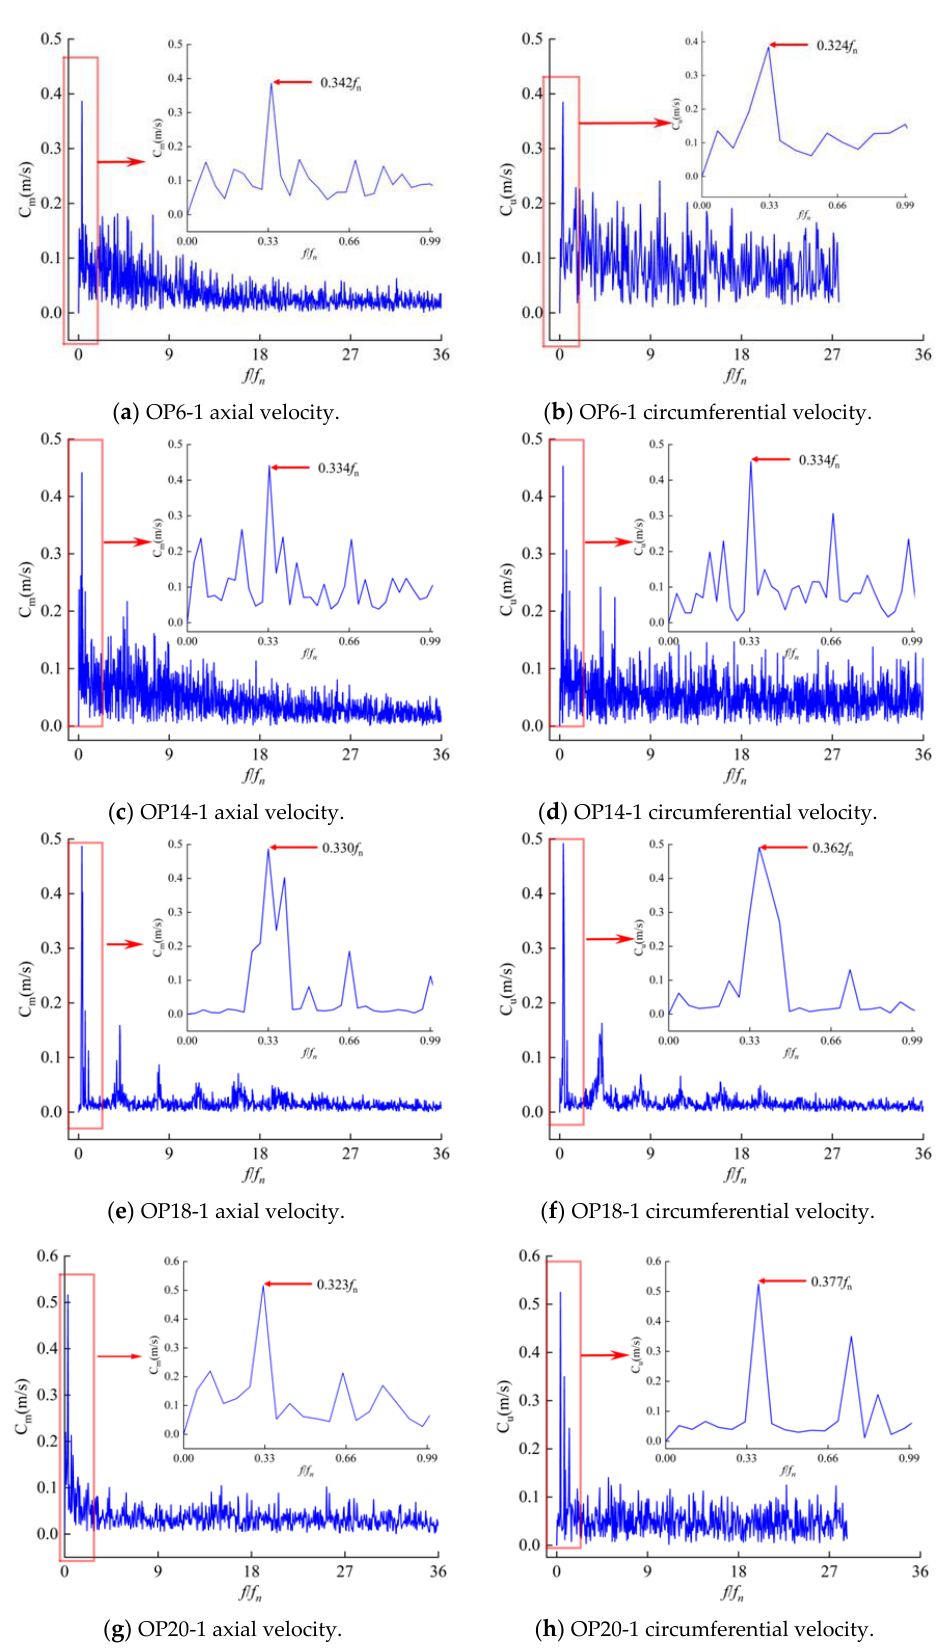
Figure 8. Frequency domain diagram of axial and tangential velocity pulsations under turbine mode.